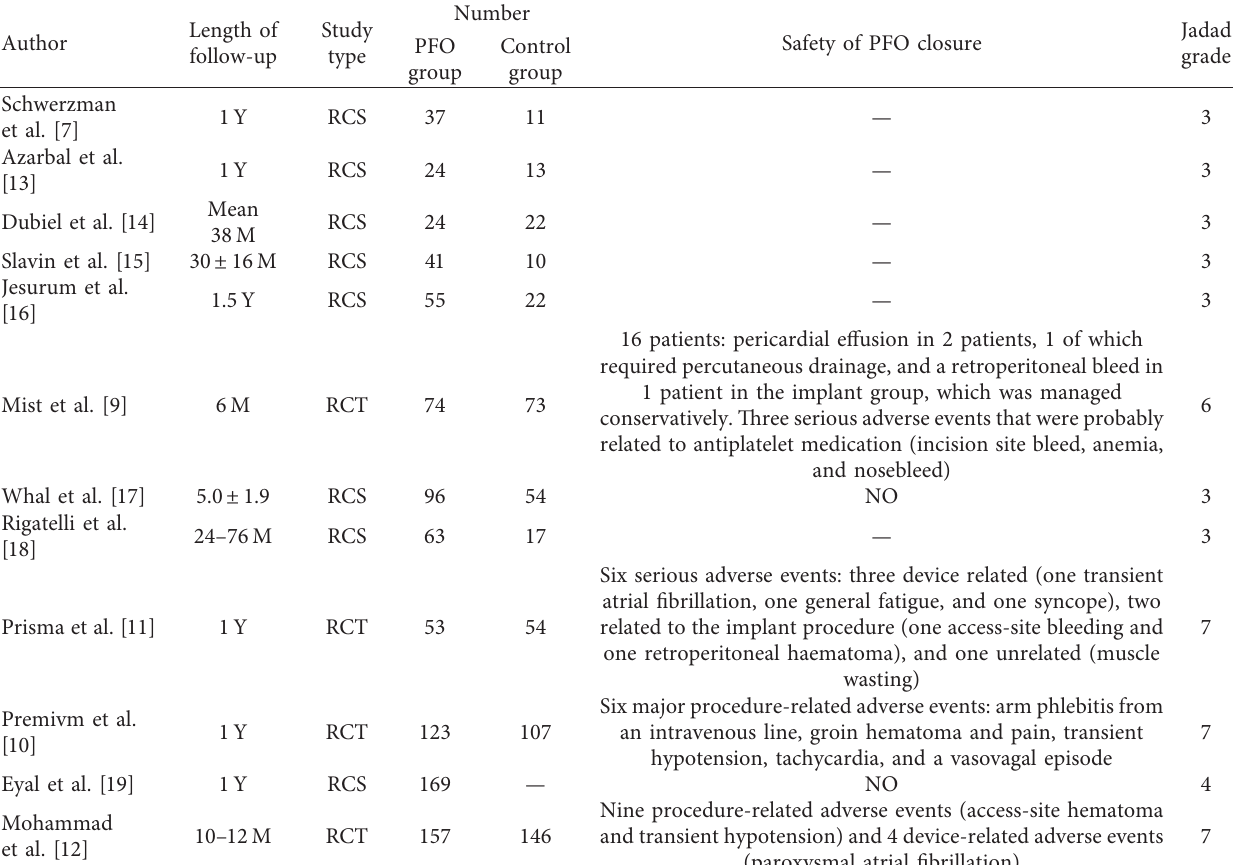
Table 1: Characteristics of included studies.